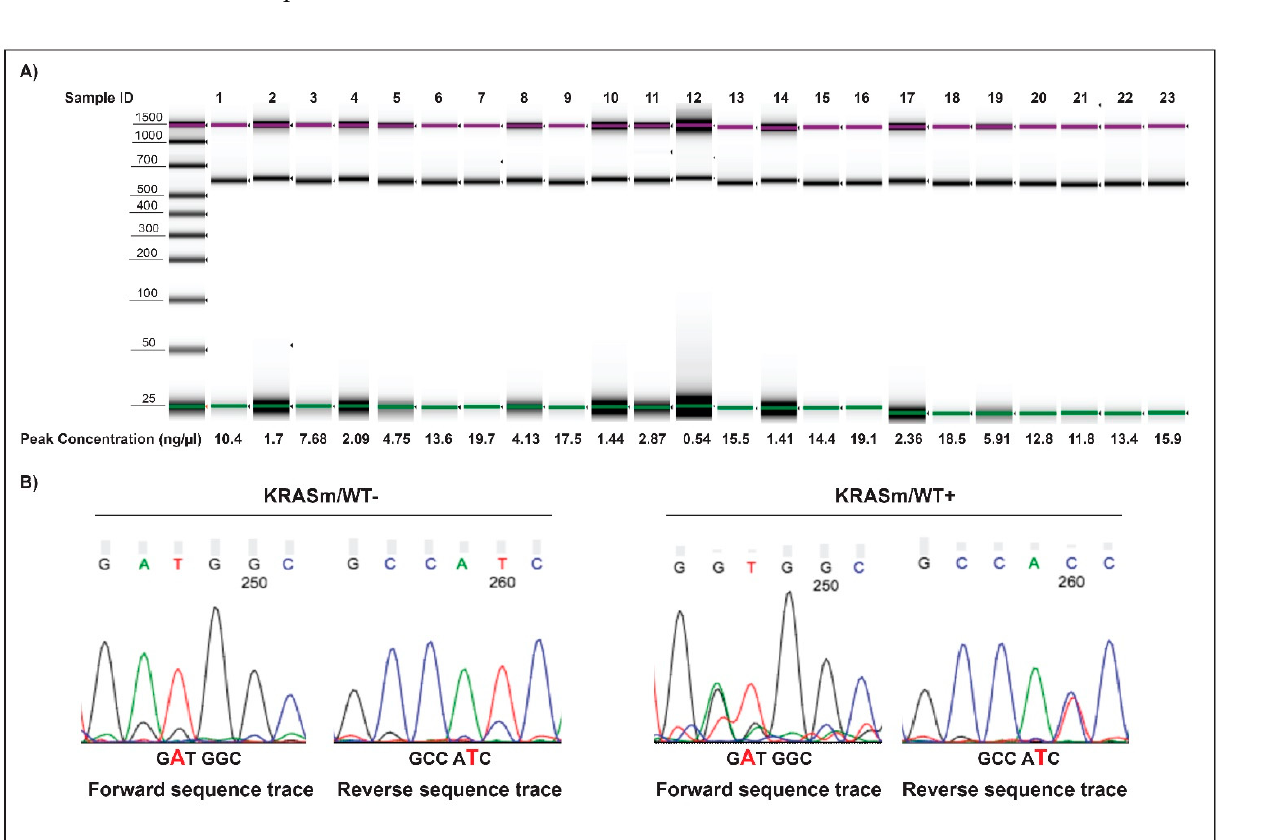
Figure 7. Amplicons and electropherogram of 23 microdissected NSCLC surgical specimens. Amplicons along with DNA concentration of the 23 microdissected biospecimens analyzed by PCR are displayed in ( A ). Examples of sequencing electropherograms with forward and reverse sequence of KRASm/WT+ and KRASm/WT − samples harboring a KRAS G12D mutation are shown in ( B ). Samples were classified as KRASm/WT − when a single peak was detected at the mutation site.